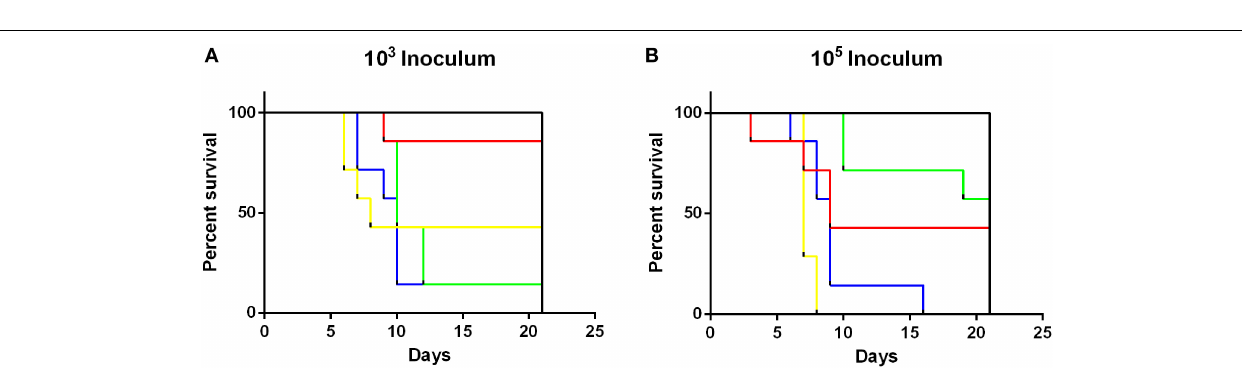
FIGURE 3 | Survival curves for mice inoculated with either 10 3 or 10 5 CFU of S. Typhimurium definitive types. S . Typhimurium definitive types DT44 (red), DT135 (yellow), DT170 = 08 (green) and DT193 (blue) exhibited significantly greater mortality at both the 10 3 (A) and 10 5 (B) dose, than all